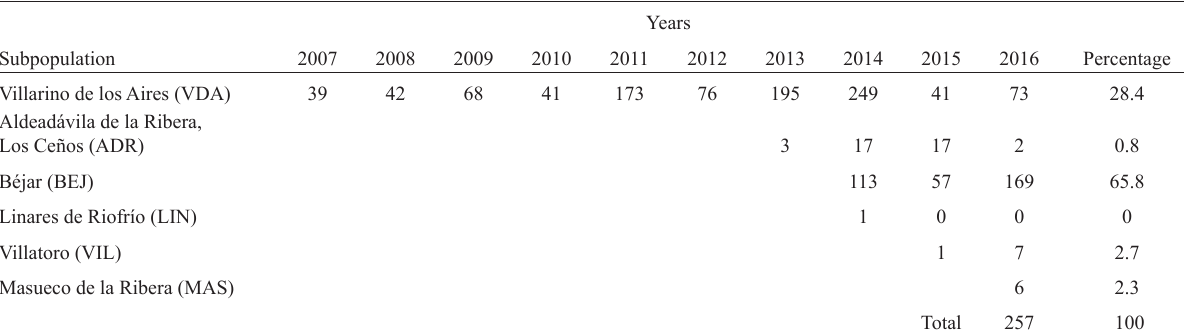
Table 3. Evolution in the number of reproductive individuals during the corresponding study period for each subpopulation of Delphinium fissum subsp. sordidum .